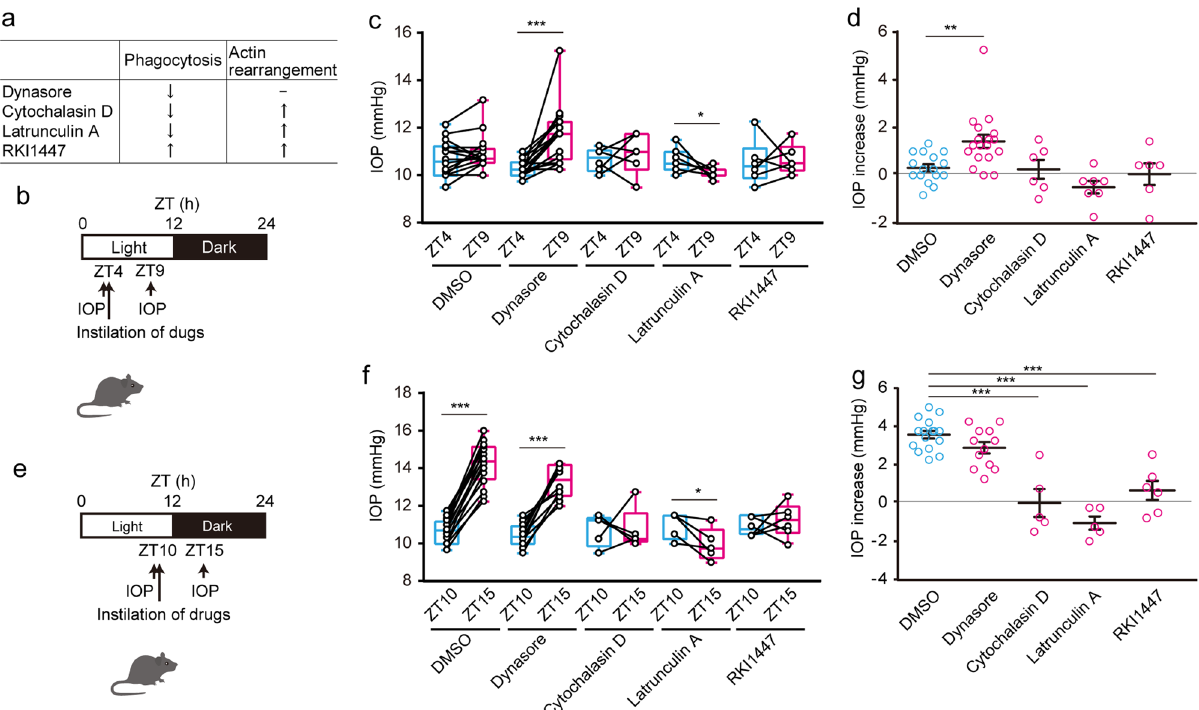
Fig. 2 Involvement of trabecular meshwork (TM) phagocytosis on diurnal IOP reduction in mice. a – d Effect of phagocytosis regulatory drugs ( a ) on diurnal IOP increase in mice. b Mice were administered an instillation of Dynamin-mediated phagocytosis inhibitor (Dynasore; 1 mM), inhibitors of actin polymerization and phagocytosis (cytochalasin D; 100 µ M, latrunculin A; 100 µ M), and cytoskeleton disruptor/phagocytosis activator (ROCK inhibitor RKI1447; 1 mM) at ZT4 and IOP were measured at ZT9. c Instillation with Dynasore signi fi cantly increased IOP, whereas latrunculin A decreased IOP (paired t-test, * p < 0.05, *** p < 0.001). Data are presented as box-and-whisker plots with individual data ( n = 6 – 18). d Individual data also showed